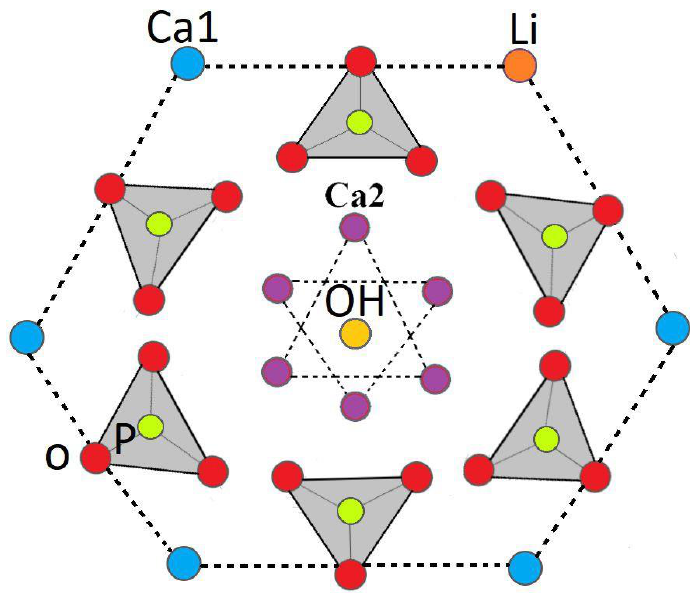
Figure 10. Schematic of Ca1 substitutional sites for Li.